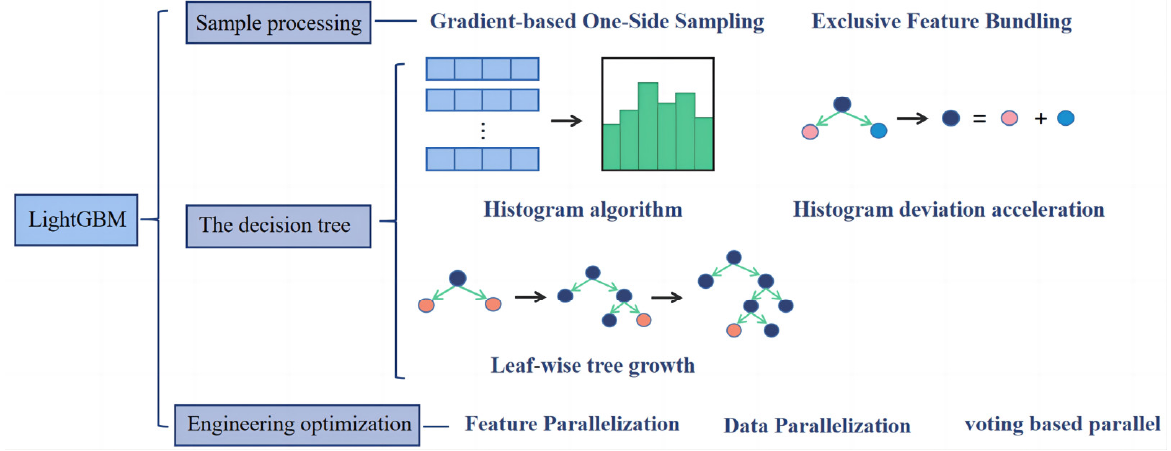
Figure 7. Schematic diagram of LightGBM optimization methods.